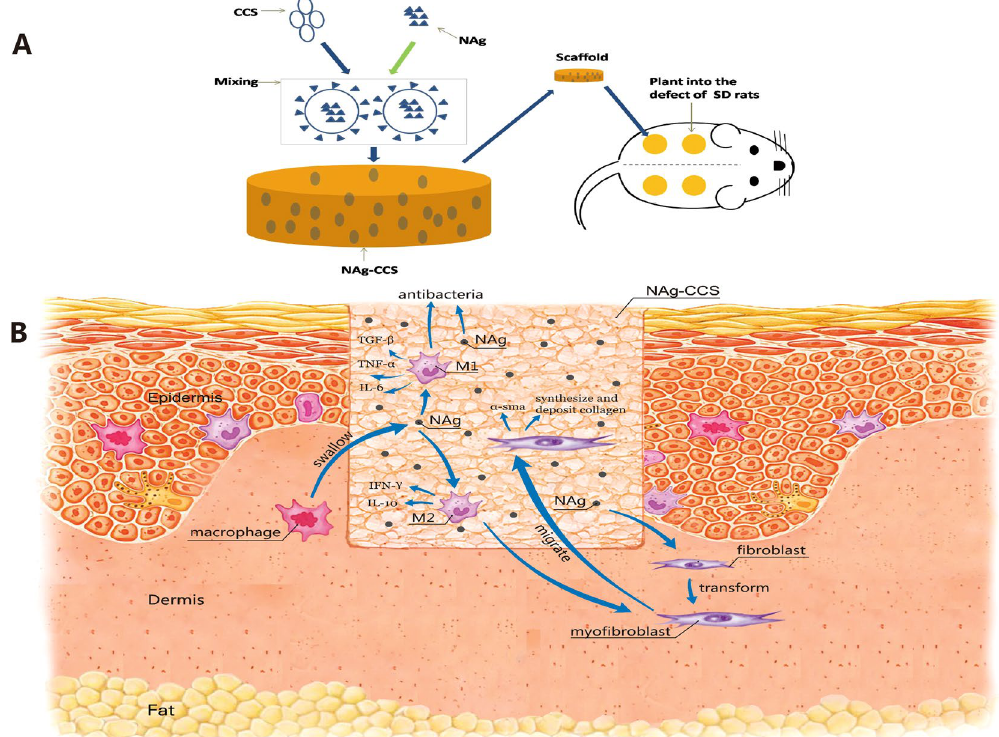
Figure 1. General view of our study. ( A ) Graphic illustration of NAg-CCS scaffold implanted into the defects of male SD rats. ( B ) The possible mechanisms of NAg accelerated cutaneous wound